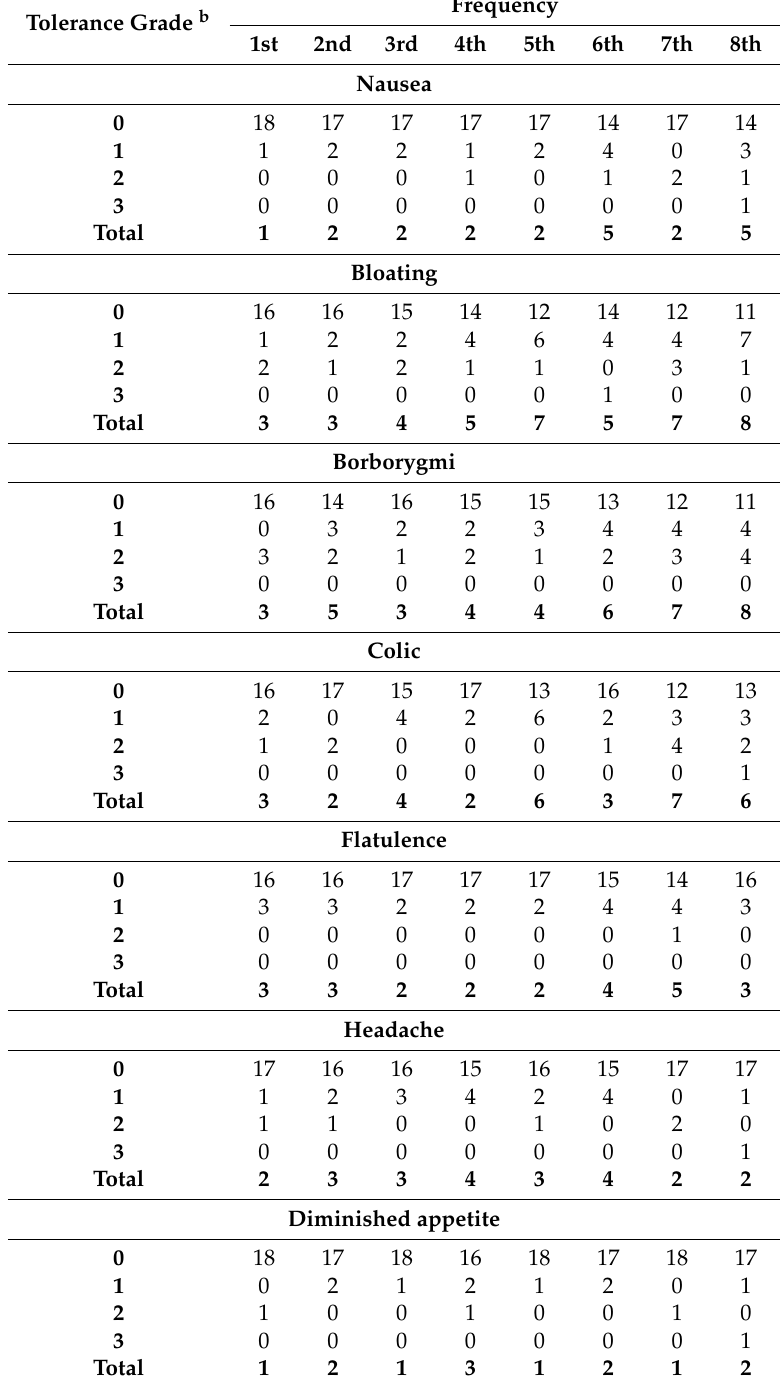
Table 9. GI symptoms in the 24 h following the consumption of the test drinks containing D-allulose, for regular ingestion (number of subjects reporting symptoms, n = 19 a